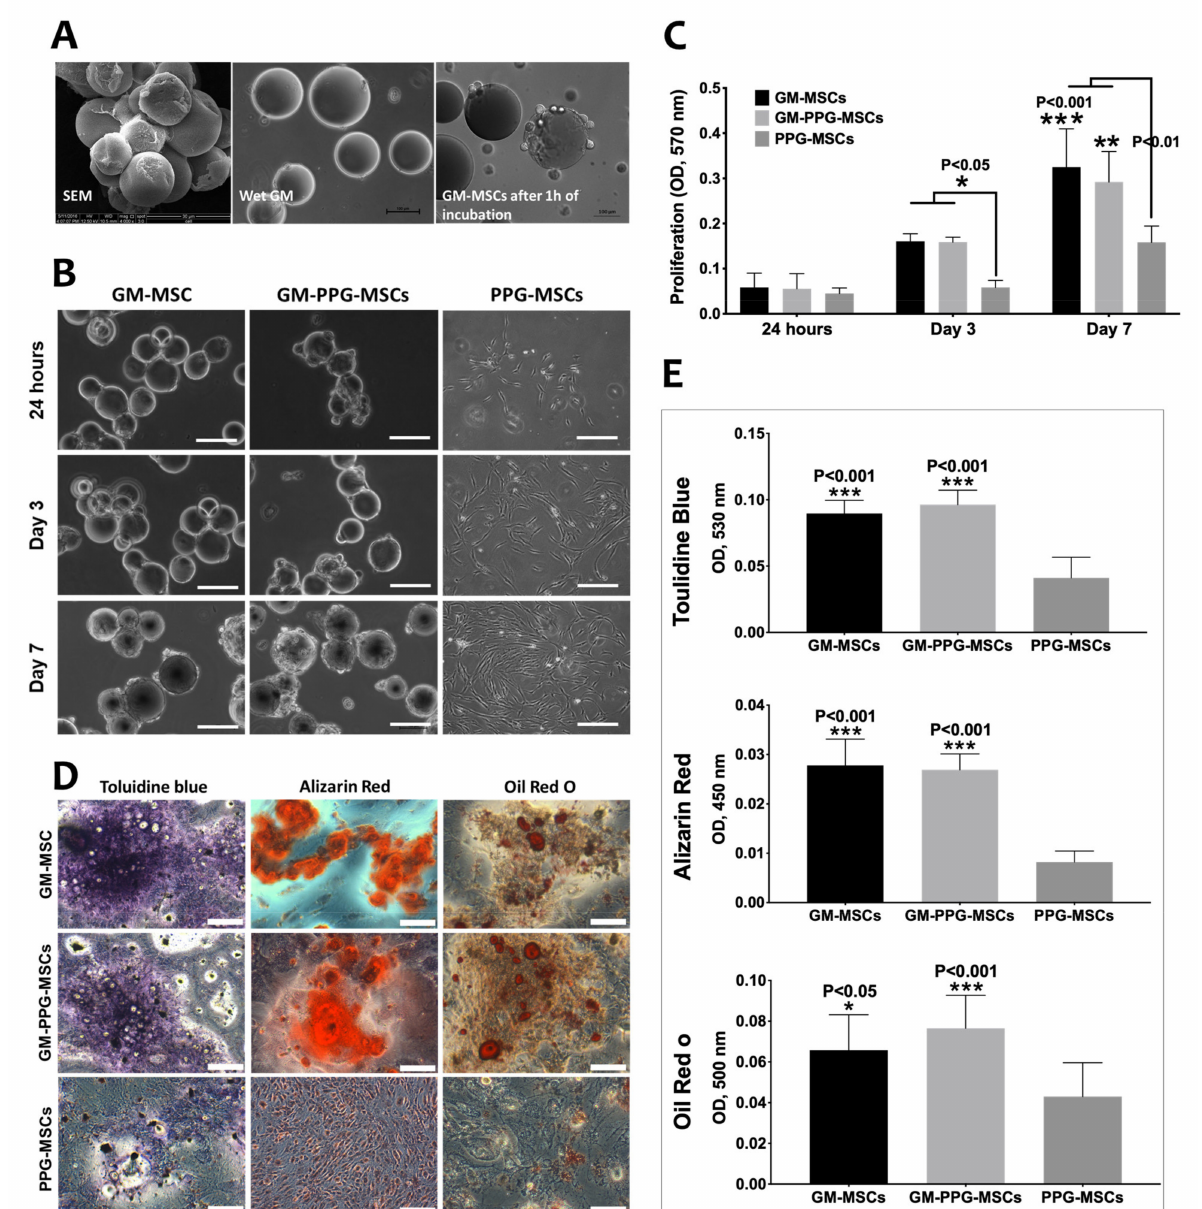
Figure 4. The effect of PPG on MSCs’ proliferation and differentiation in 3D culture. ( A ) Scanning electron microscopy of the GM. ( B ) The morphology of GM-MSCs as compared to the monolayer culture following day 1, 3 and 7 in culture. ( C ) The effect of PPG on MSC proliferation in a 3D culture. ( D ) The effect of antibody conjugation on multilineage differentiation of MSCs in a 3D culture. ( E ) Spectrophotometry for staining indicates that both 3D culture groups GM-MSCs and GM-PPG- MSCs groups significantly increased the staining of all lineage differentiation compared to the monolayer PPG-MSCs group. Scale bar measures 100 µ m (* p < 0.05, ** p < 0.01, *** p <